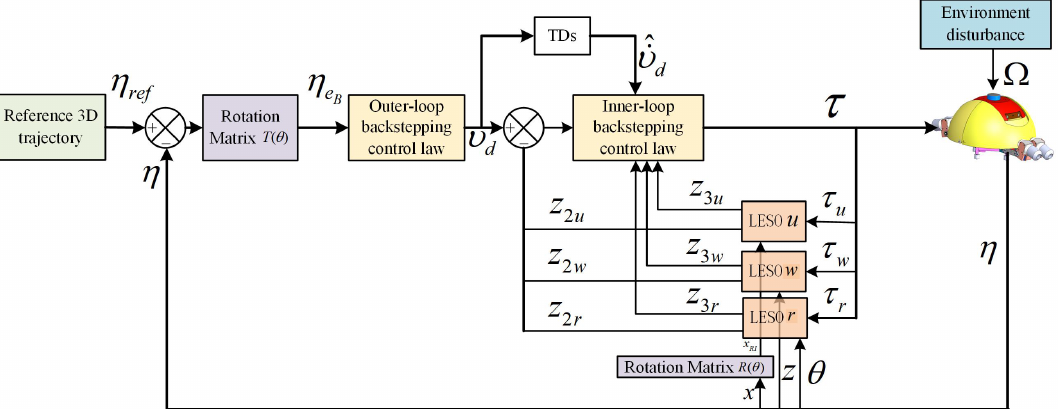
Figure 7. The scheme of the double closed-loop backstepping controller with an LESO and